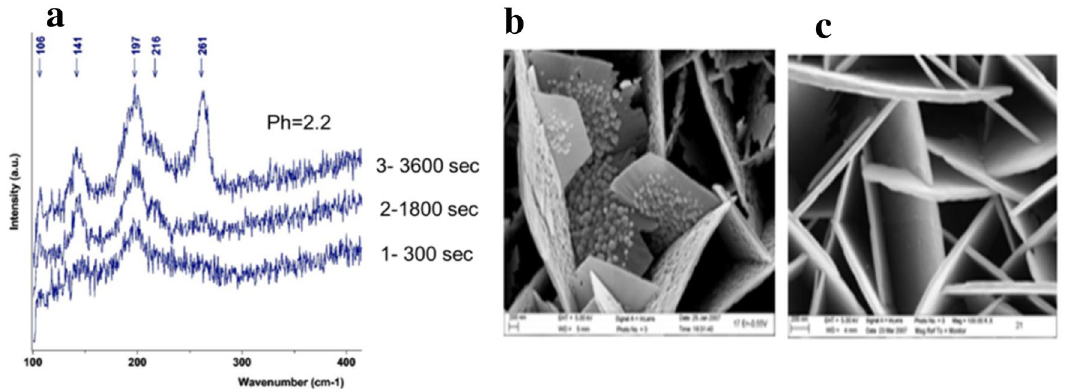
Fig. 10 a Raman spectra of CuSe films obtained after immersion at OCP in Cu(II)–Se(IV) solutions (pH 2.2) (reprinted with permis- sion from Ramdani et al. [105] Copyright 2007, The Electrochemical Society), b SEM of as-deposited Cu–Se at V = − 0.55 V/MSE, [Se/